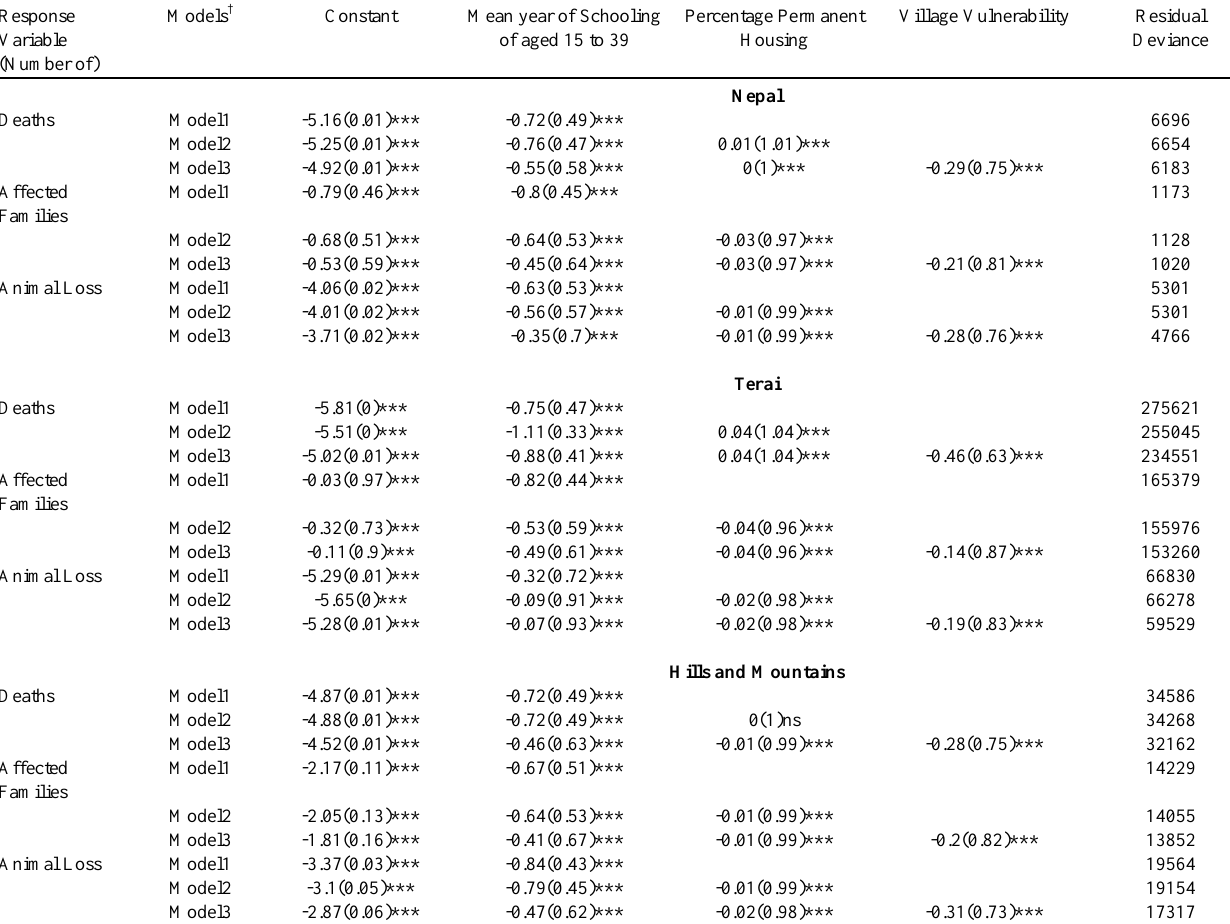
Table 2 . Coefficients (exponents in parentheses) of the Poisson regression analysis of number of deaths, number of families affected, and number of animals lost on mean years of schooling of 15 to 39-years-old and other